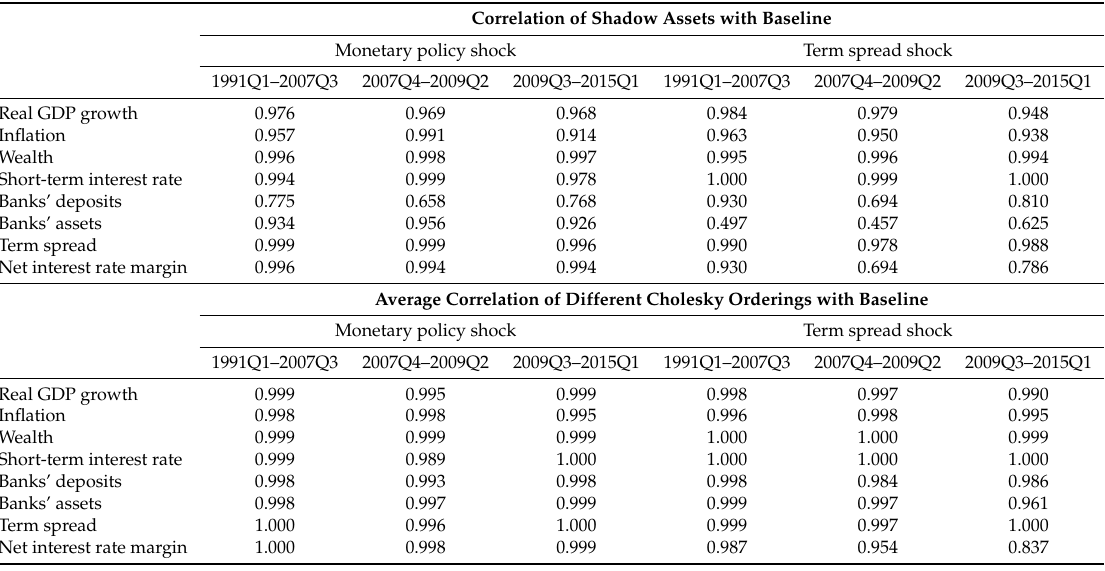
Table 3. Correlation of median impulse